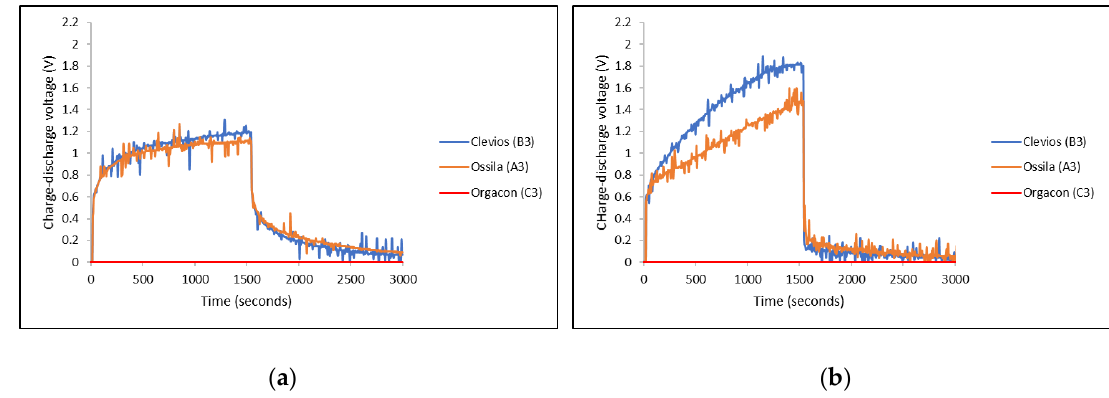
Figure 9. Charge-discharge characteristics of devices of different types of PEDOT:PSS using SS/Ag-PBO electrodes with different polarity of the applied voltage: ( a ) SS(+3 V)/Ag-PBO(0 V) and ( b ) SS(0 V)/Ag-PBO(+3